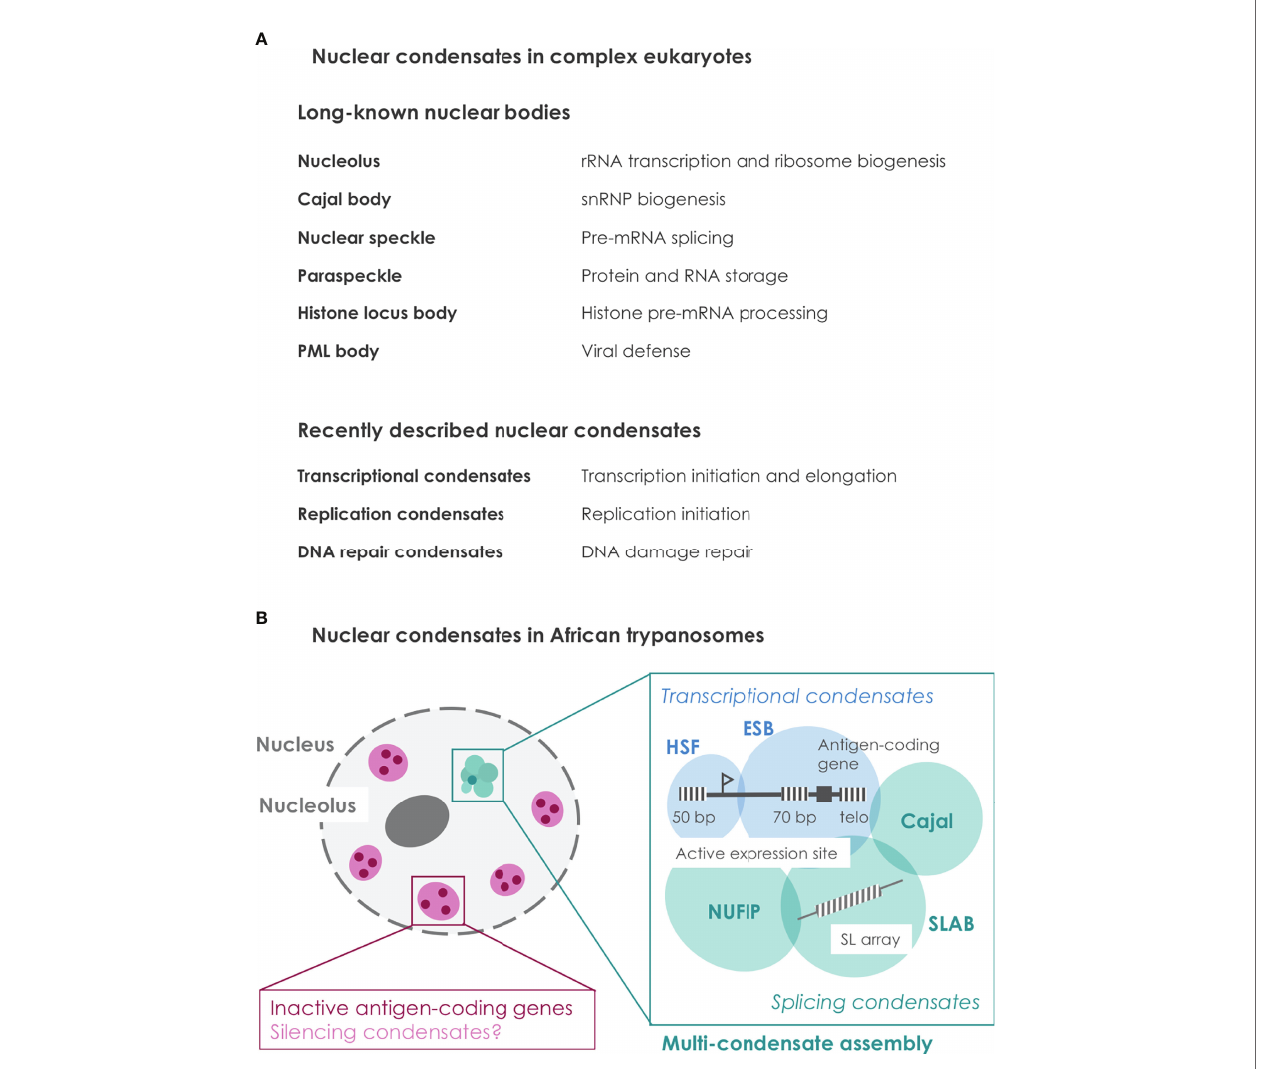
FIGURE 1 | Nuclear condensates in complex eukaryotes and in African trypanosomes. (A) Overview of nuclear condensates characterized in complex eukaryotes. While some nuclear bodies are stable during G1 phase and have been described decades ago, other condensates form more dynamically and have been described only recently. A brief description of the respective condensate function is provided (Spegg and Altmeyer, 2021). (B) Illustration of so far known nuclear condensates in African trypanosomes. The active antigen gene is embedded within a multi-condensate assembly (Faria et al., 2021; Budzak et al., 2022). Spatial integration of transcription and splicing condensates at the active antigen gene presumably coordinates the multi-step process of antigen expression. In contrast, inactive antigen genes are located away from the multi-condensate assembly. Transcriptional silencing of antigen genes might be mediated by condensate formation. Repetitive sequences are illustrated as striped boxes. ESB, expression site body; HSF, highly SUMOylated focus; SLAB, spliced leader array body; Cajal, Cajal body; NUFIP, NUFIP body; SL, Spliced leader; 50 bp, 50 bp repeats; 70 bp, 70 bp repeats; telo,